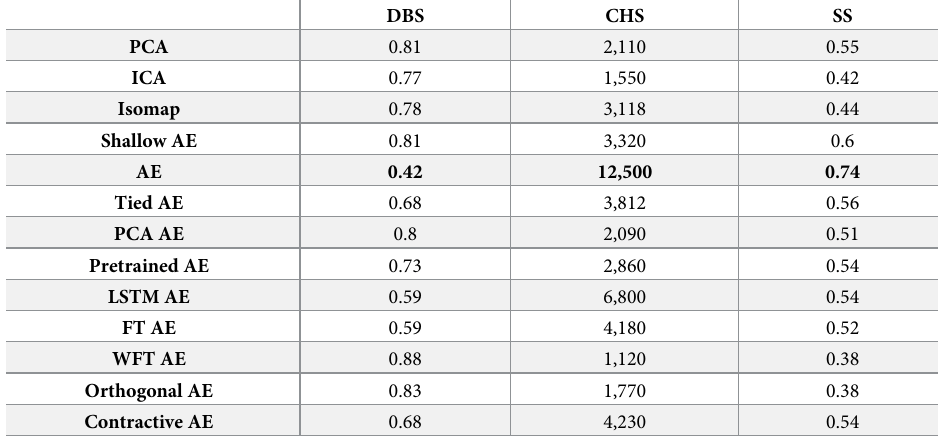
Table 12. Comparison of different autoencoder variations vs state-of-the-art methods on real data channel 26, the optimal value of neighbours for Isomap was found as 30 through grid search. The metrics indicate that for this dataset the AE variant is able to outperform the conventional feature extraction algorithm with regard to all metrics while the other variants have similar performances to that of PCA, ICA and Isomap. The values indicating the highest performance for each metric have been